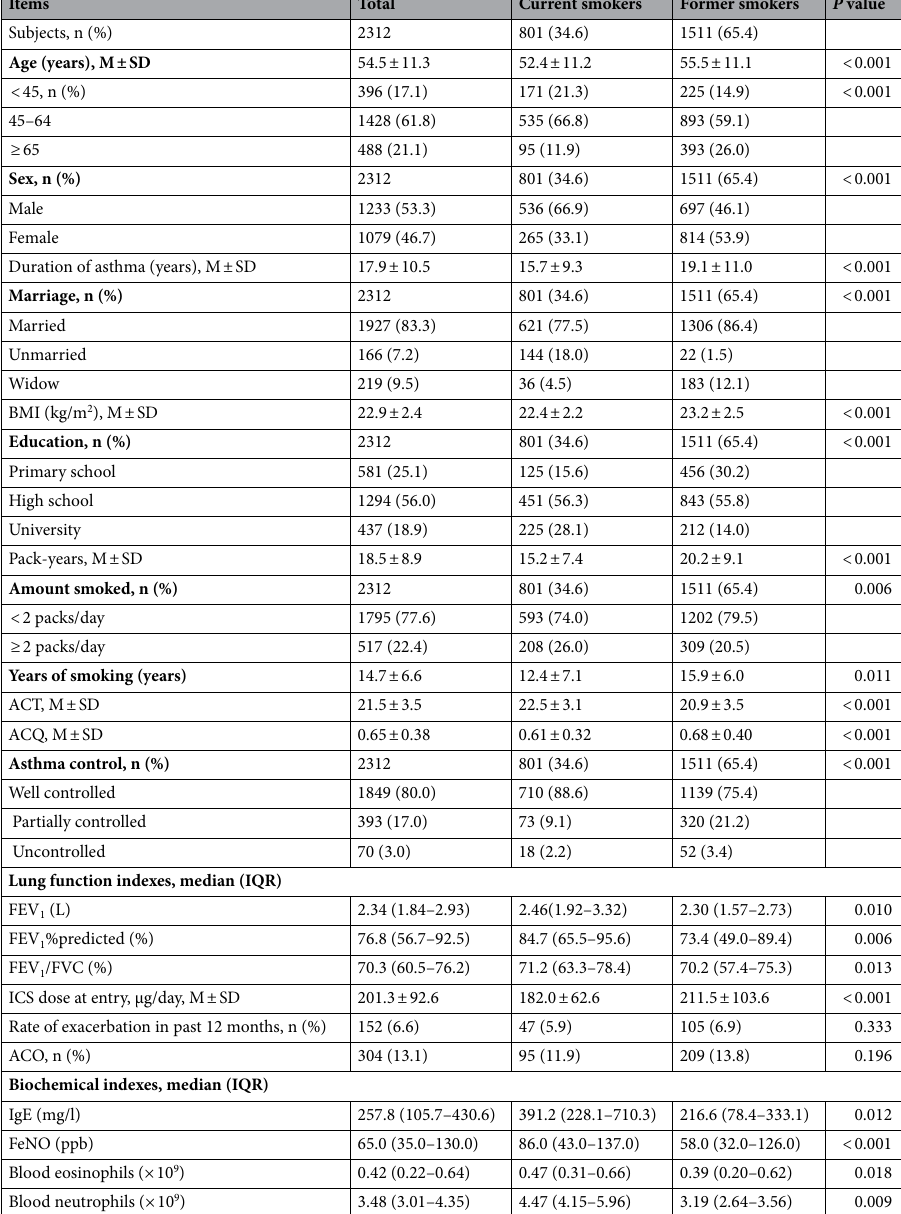
Table 1. Clinical characteristics of participants. Comparisons were determined using Student’s t test and the Mann–Whitney U test between two groups, and the chi-square test, one-way analysis of variance (ANOVA) or the Kruskal–Wallis test followed by Dunn’s multiple comparisons test between three groups. P < 0.05 was considered statistically significant. ACQ asthma control questionnaire, ACO asthma and chronic